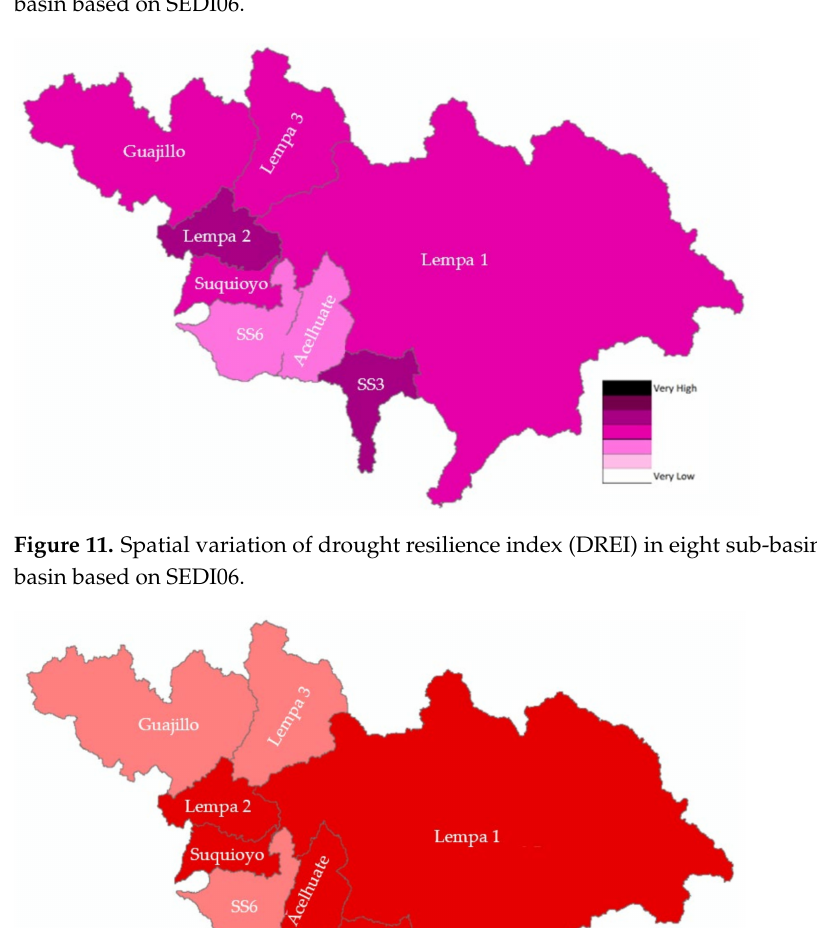
Figure 10. Spatial variation of drought vulnerability index (DVI) in eight sub-basins of Lempa River basin based on SEDI06.